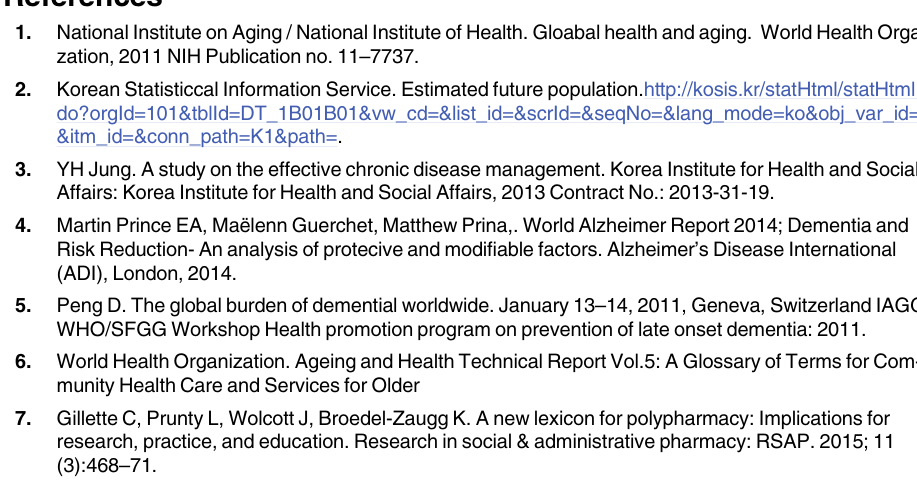
S4 Table. Interaction between polypharmacy and predictor variables.